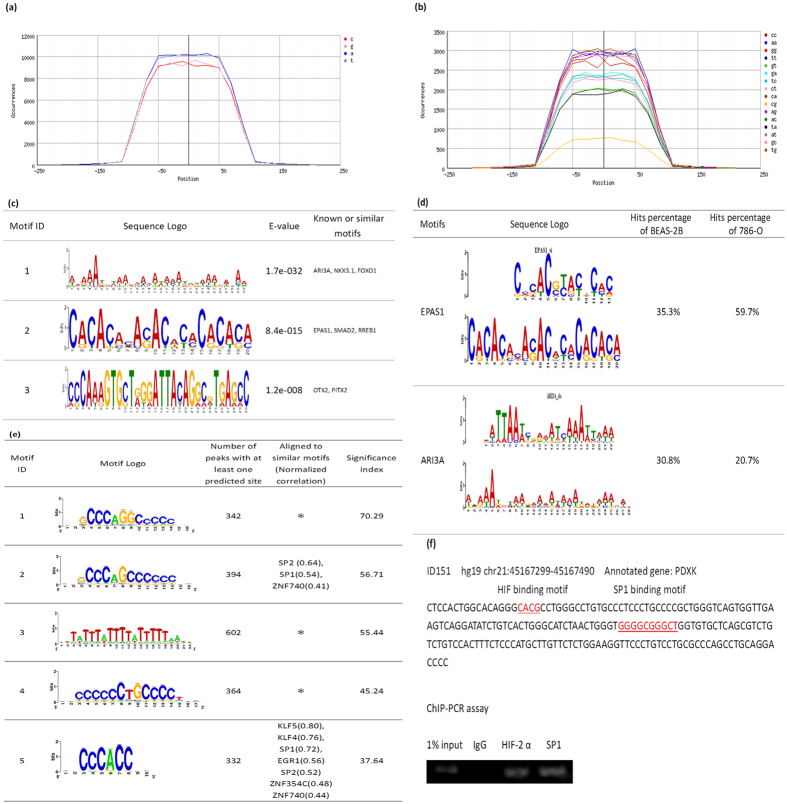
Analysis of HIF-2α binding motifs.HIF-2α binding profile of single nucleotide (a) or dinucleotide (b) composition generated by using RSAT. (c) The three most significant HIF-2α binding motifs under normoxia produced by MEME. (d) PWM Tools was used to scan the HOCOMOCO for EPAS1 motif 1 and ARI3A motif 2 against BEAS-2B and 786-O. (e) Analysis of HIF-2α potential heterodimers binding motif under normoxia. Results were generated by using dyad-analysis in RSAT. Significance index (sig) was computed by “sig = −log10(E value)” and E value = P value × number of tested character. Higher value means less error. *, de novo binding motifs that did not match those of any of known DNA binding proteins in the databank. (f) Co-enrichment of HIF-2α and SP-1 on Peak ID 151 annotated to PDXK.